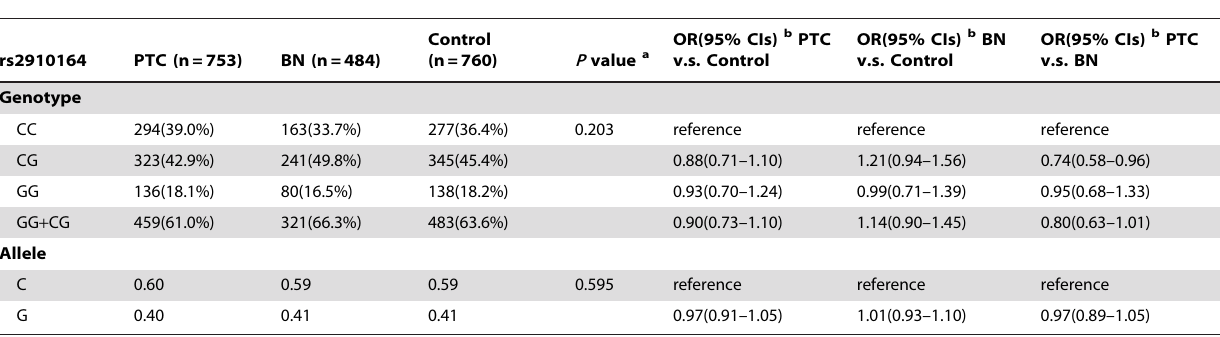
Table 2. Distribution of rs2910164 genotypes and alleles in cases and controls, and their associations with risk of thyroid tumor.